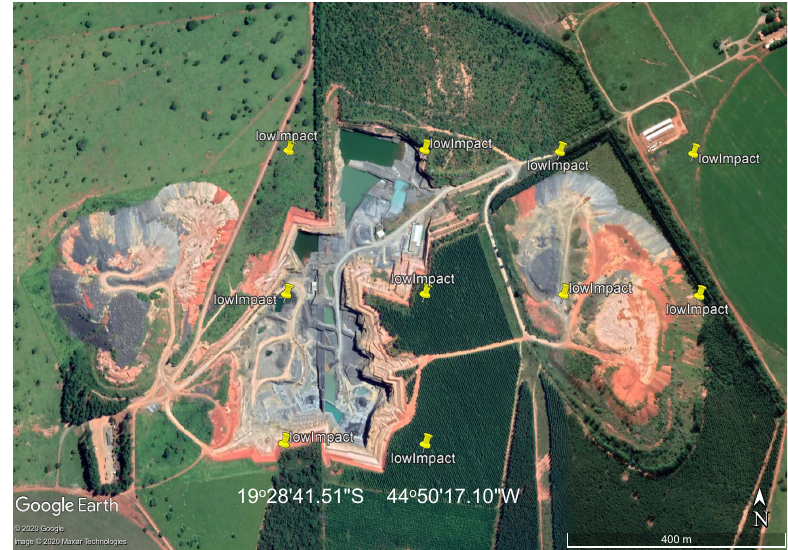
Figure 9. Mines and tailings dams indicated by yellow marks on Google